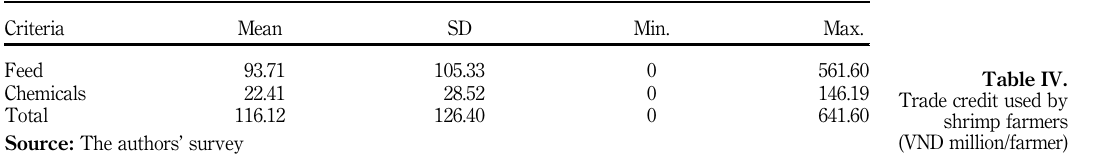
Table IV. Trade credit used by shrimp farmers (VND